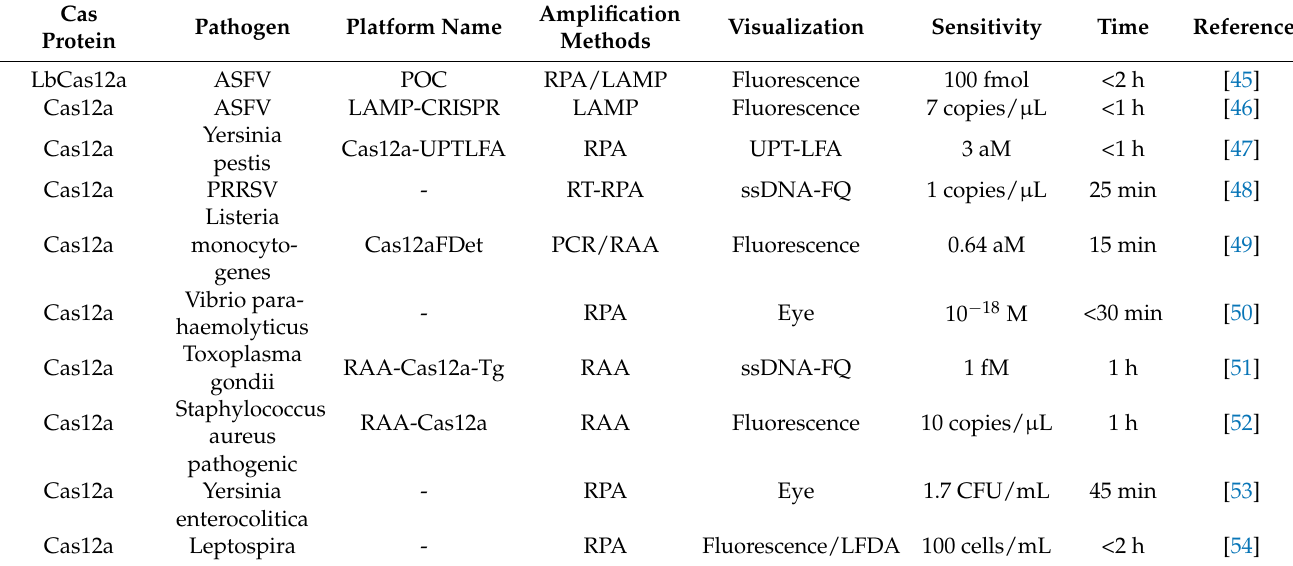
Table 2. More applications of CRISPR/Cas12a in pathogen